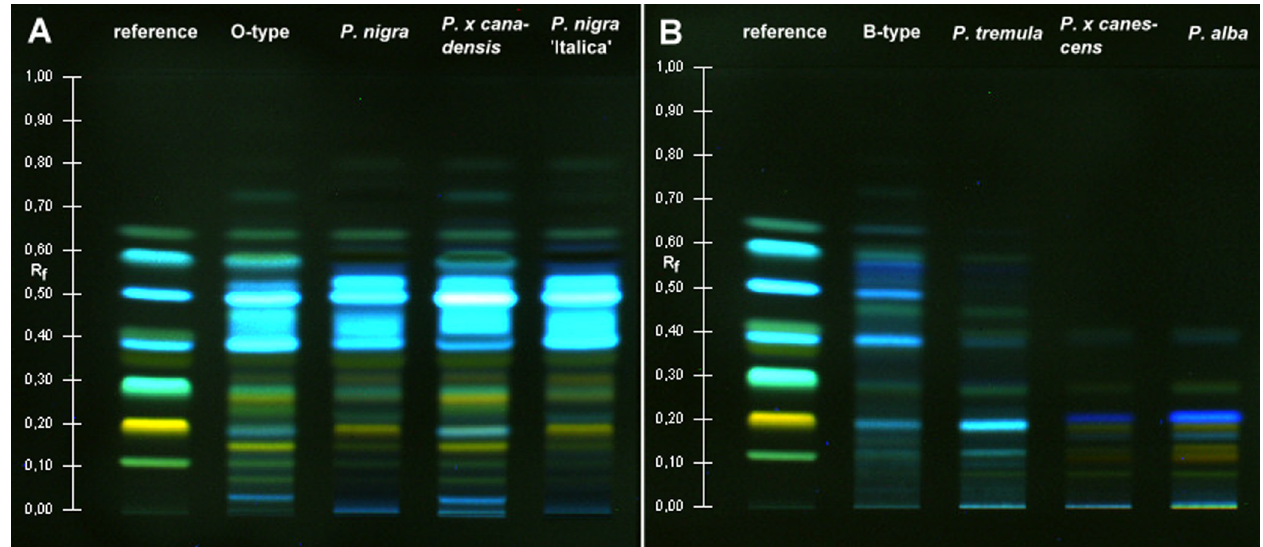
Fig. 3: TLC fingerprints of bud extracts from (A) black poplars (each 10 μL) and (B) P. tremula L. (20 μL), P. x canescens (Aiton) Sm. and P. alba L. (each 30 μL) in comparison to propolis of O- and B-type, respectively (10 μL).